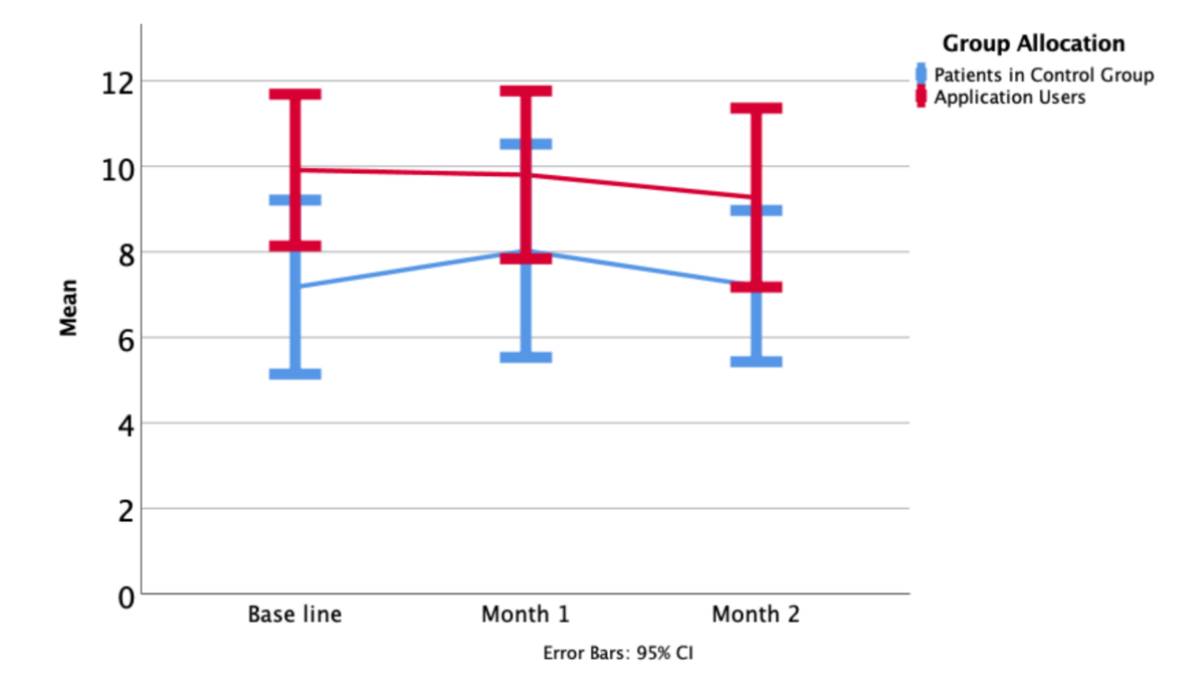
baseline, one month, or two months. Over the full duration